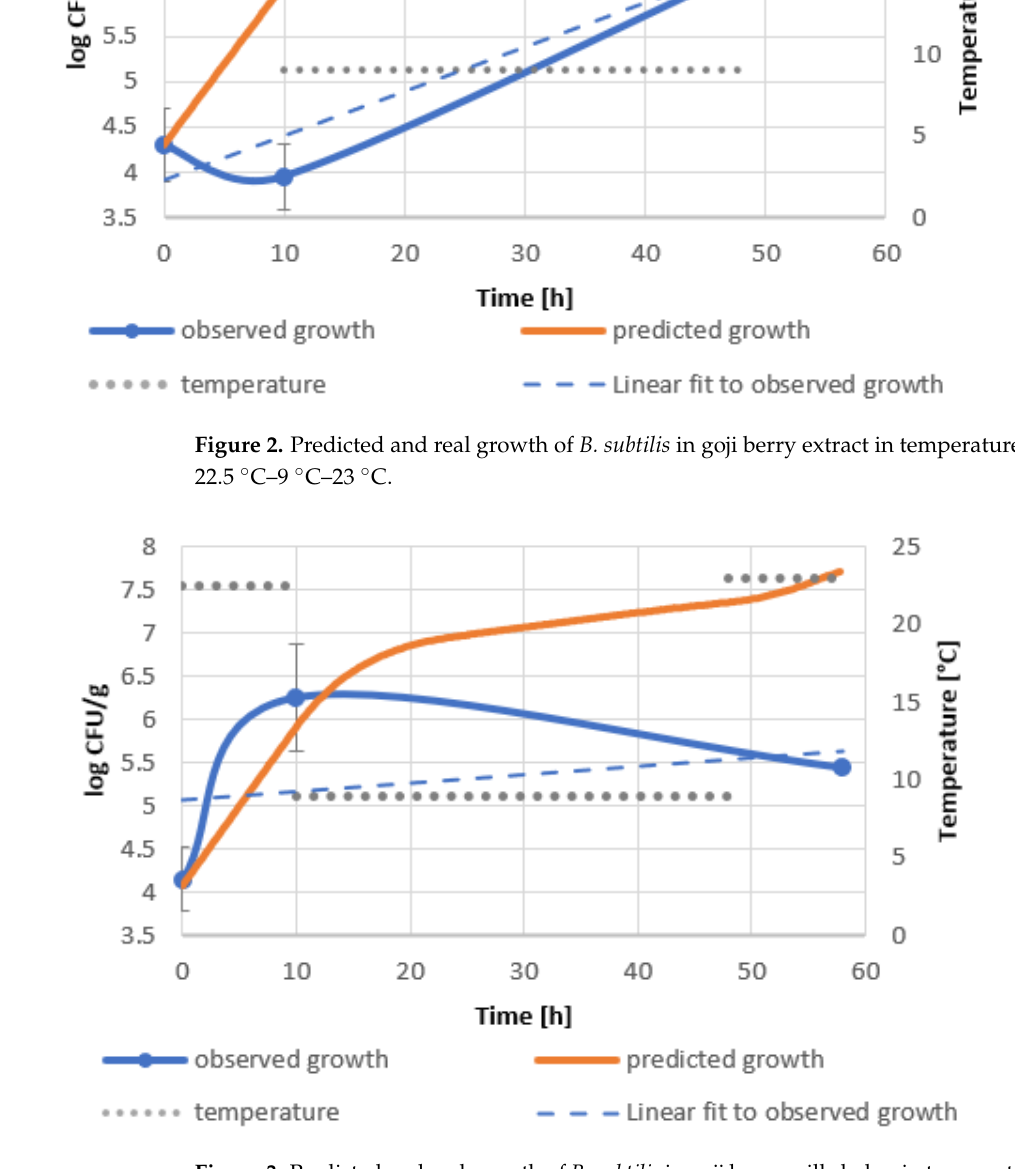
Figure 3. Predicted and real growth of B. subtilis in goji berry milkshakes in temperature shifts, profile II 22.5 ℃-9 ℃-23 ℃ .